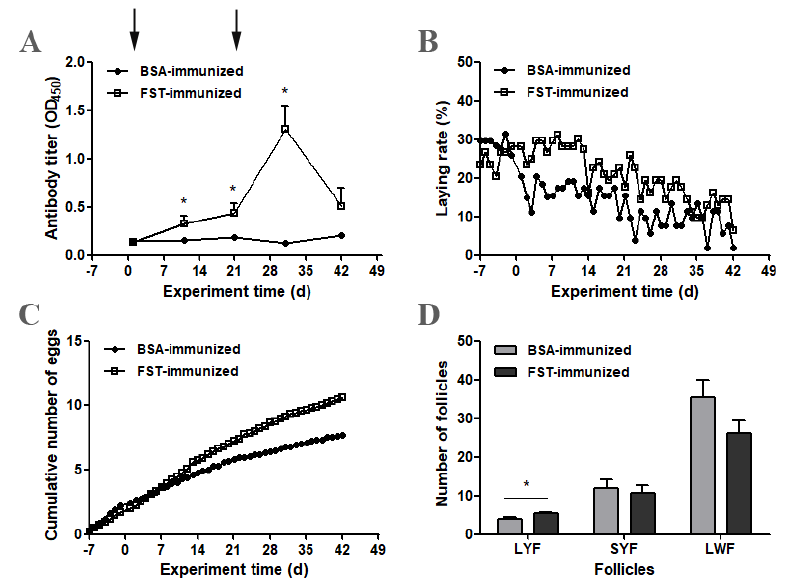
Figure 3. Changes in antibody titers, egg production and ovarian follicular development in FST- immunized or BSA-immunized control geese. ( A ) Anti-FST antibody titers ( n = 12). ( B ) The laying rate represents the average laying rates over two consecutive days. ( C ) The cumulative number of eggs laid per goose equals the total number of eggs divided by the number of geese. ( D ) The number of ovarian follicles. * represents a significant difference between the two groups at one time point ( p < 0.05). Data represent mean ± SEM.